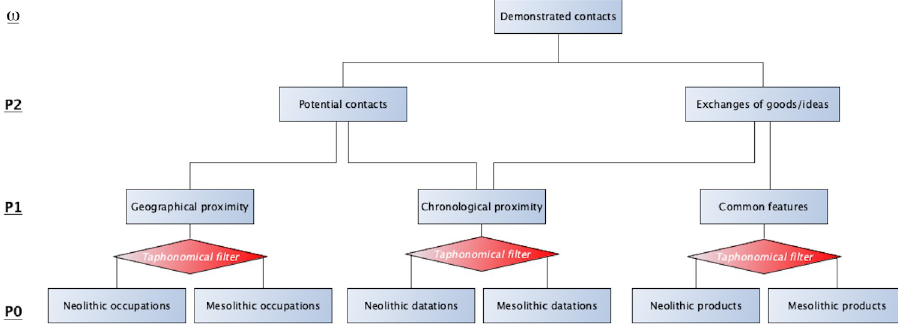
Fig 2. Logicistical diagram for establishing a hypothesis of contact between Mesolithic and Neolithic groups. Simplified logicistical diagram representing the necessary conditions for establishing a hypothesis ( ω ) of contact between prehistoric groups, in this case Mesolithic hunter-gatherers and Neolithic agro-pastoralists, on the basis of archaeological contexts and material productions. This first involves low-level propositions (P0), generally in the form of observations: Their geographical proximity must thus be demonstrated, as well as their contemporaneity (within the limits of accuracy of the absolute data) and the elements for comparison, which are generally material productions,